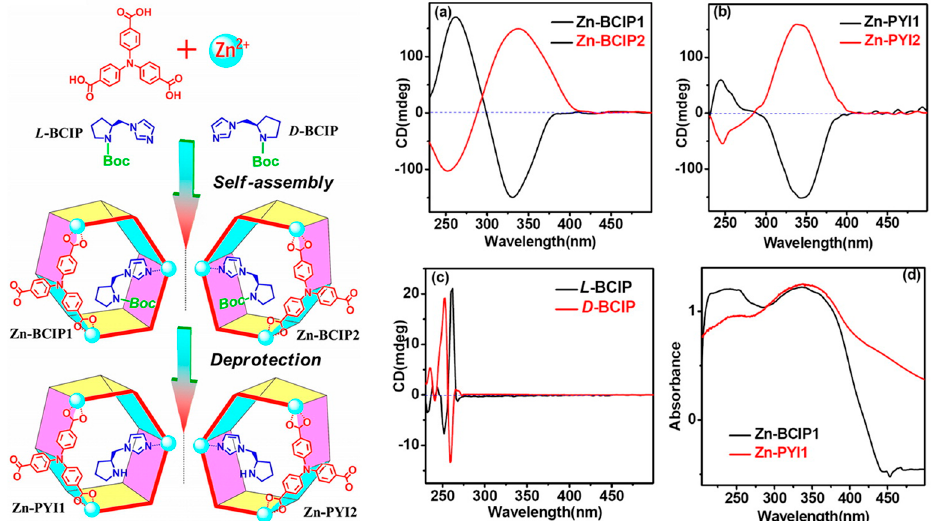
Figure 16. Synthesis and spectral characterization of chiral MOFs Zn ‐ PYI1 and Zn ‐ PYI2. Adapted with permission from Reference [114], Copyright (2012) American Chemical Society.